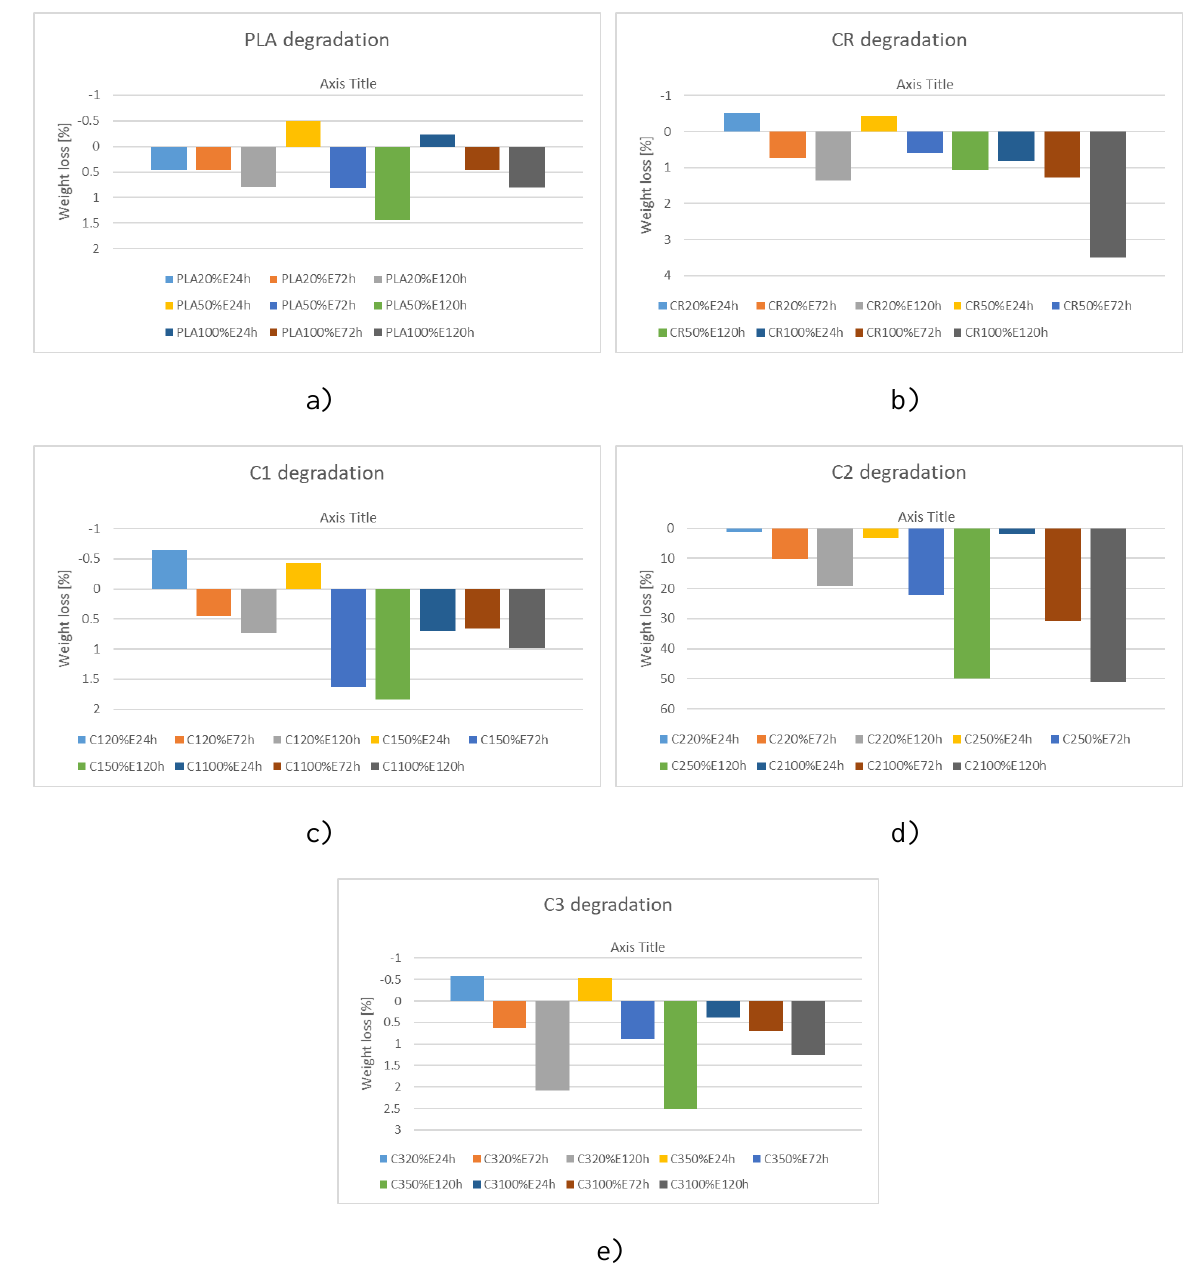
Figure 2. Weight loss percentage of PLA and its composites after enzymatic degradation, symbol explanations in Table 1 Table 2. Non-combustible matter content in the SJL residues after fibre